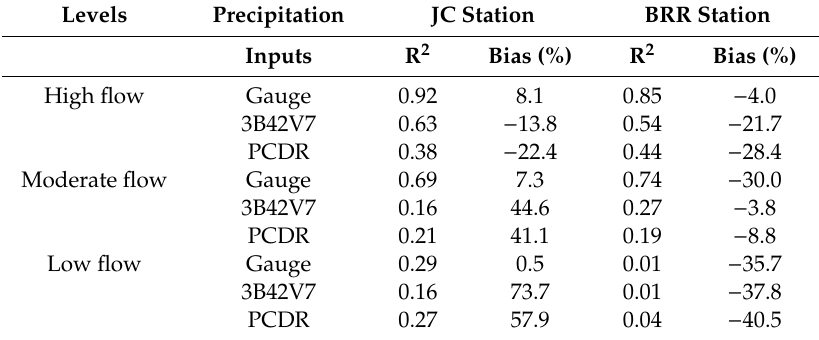
Table 4. Statistics indices of streamflow simulation forced by the three precipitation inputs at di ff erent flow levels. Levels Precipitation JC